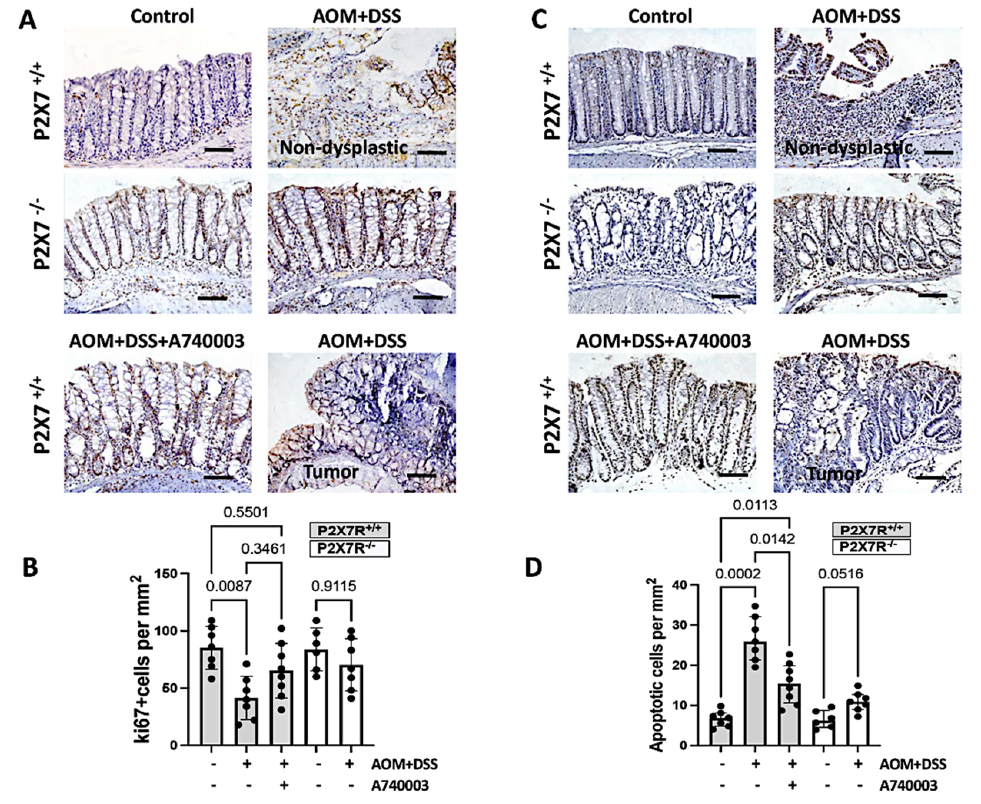
Figure 3. P2X7R blockade protects against colonic injury and apoptotic cell loss in the AOM/DSS- treated mice. Proliferating cells were immunohistochemically labeled with anti-Ki67 antibody ( A